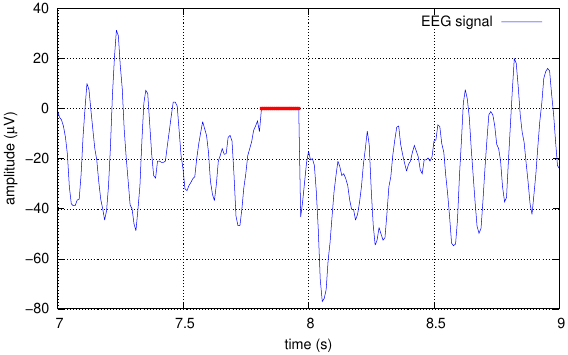
Figure 9. Example of data corrupted with a hole